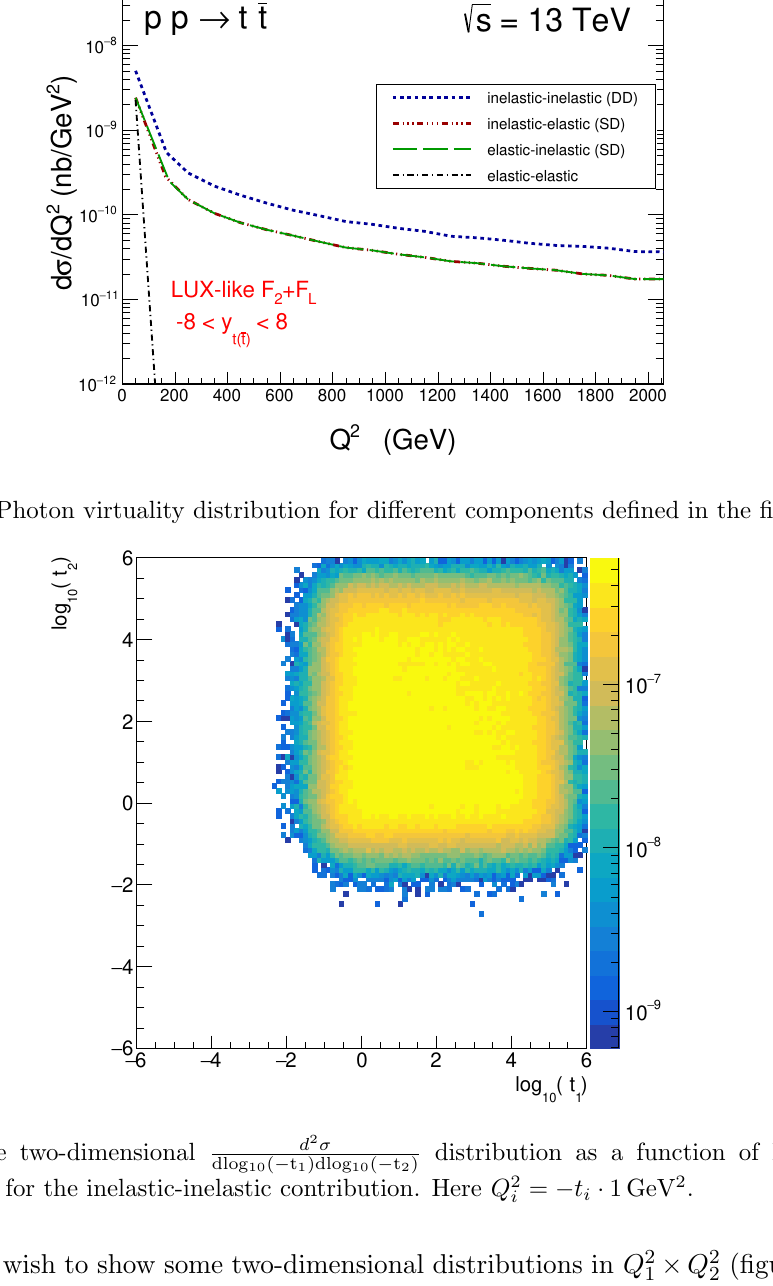
distribution as a function of log 10 ( (cid:0) t 1 ), dlog 10 ( (cid:0) t 1 )dlog 10 ( (cid:0) t 2 ) = (cid:0) t i (cid:1) 1 GeV 2 i